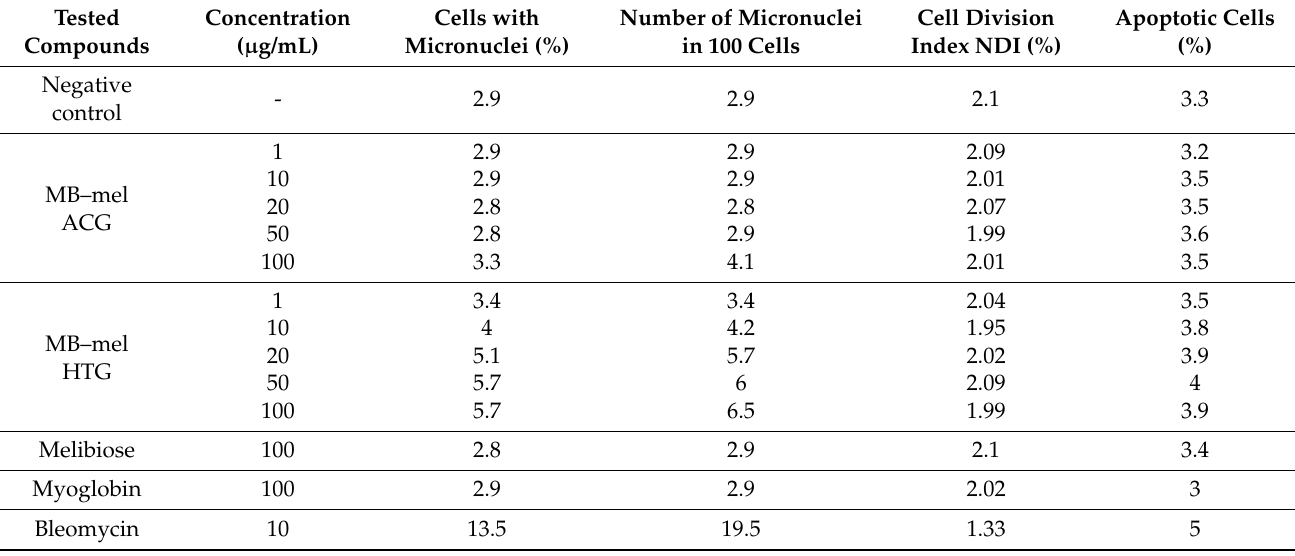
Table 4. The effect of advanced glycation end-products on BEAS-2B cells.